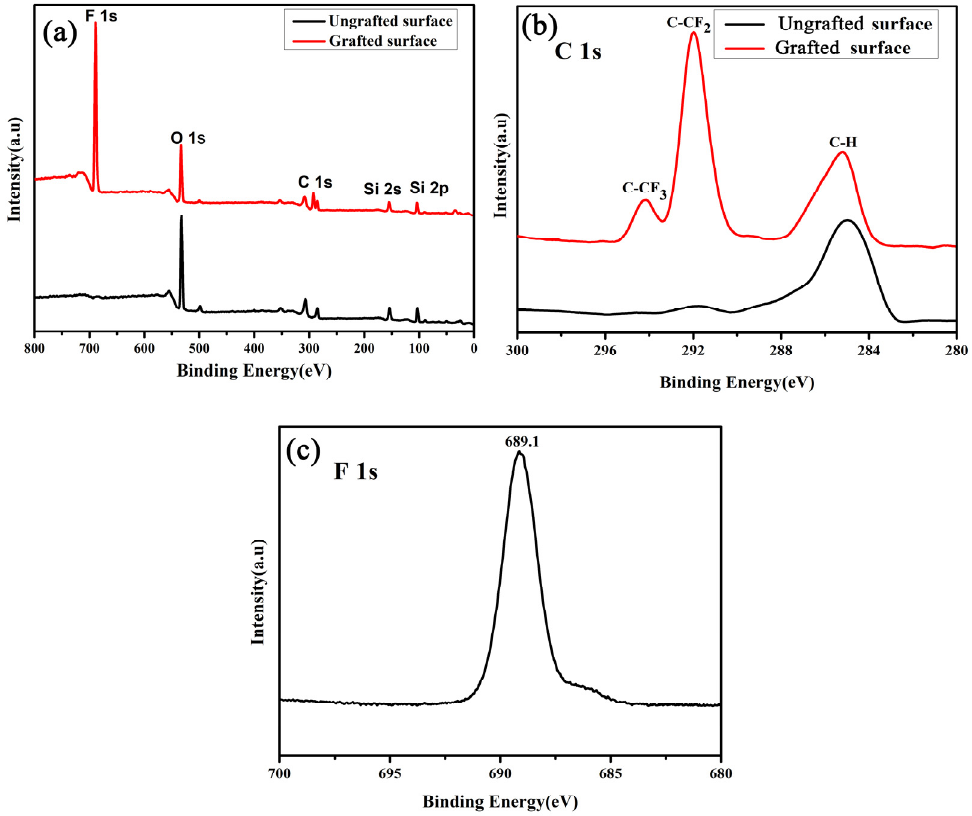
Figure 10. ( a ) Wide-range, ( b ) high-resolution C 1s and ( c ) F 1s XPS spectra of the glass-ceramic